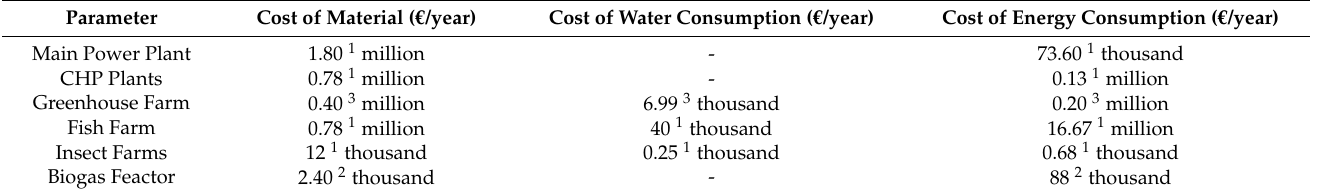
Table 3. Life cycle cost parameters of products.